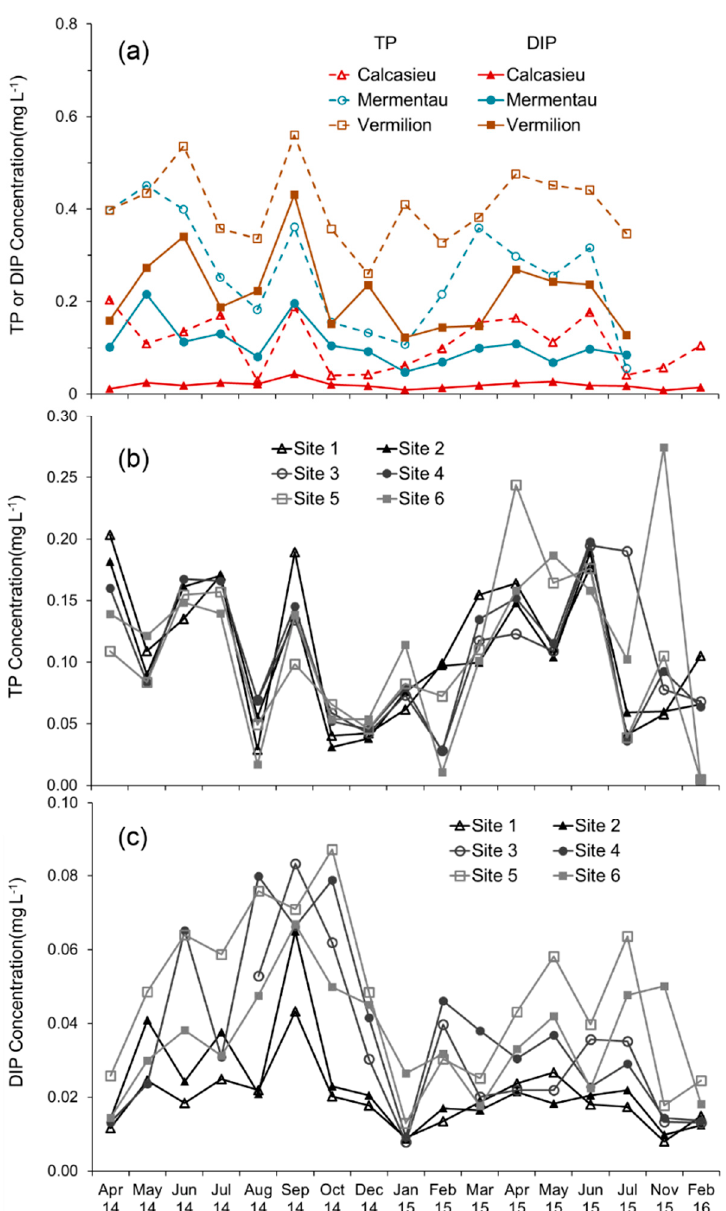
Figure 4. Concentrations of TP and DIP in the Calcasieu, Mermentau, and Vermilion Rivers from April 2014 to February 2016; The Mermentau and Vermilion Rivers were only sampled from April 2014 to July 2015; Data for the Calcasieu, Mermentau, and Vermilion Rivers in ( a ) are data for sites 1, 7, and 8; ( b ) TP concentration in the Calcasieu River; ( c ) DIP concentration in the Calcasieu River. 3.3. Comparison between TP Loading during 1990–2009 and 2010–2017